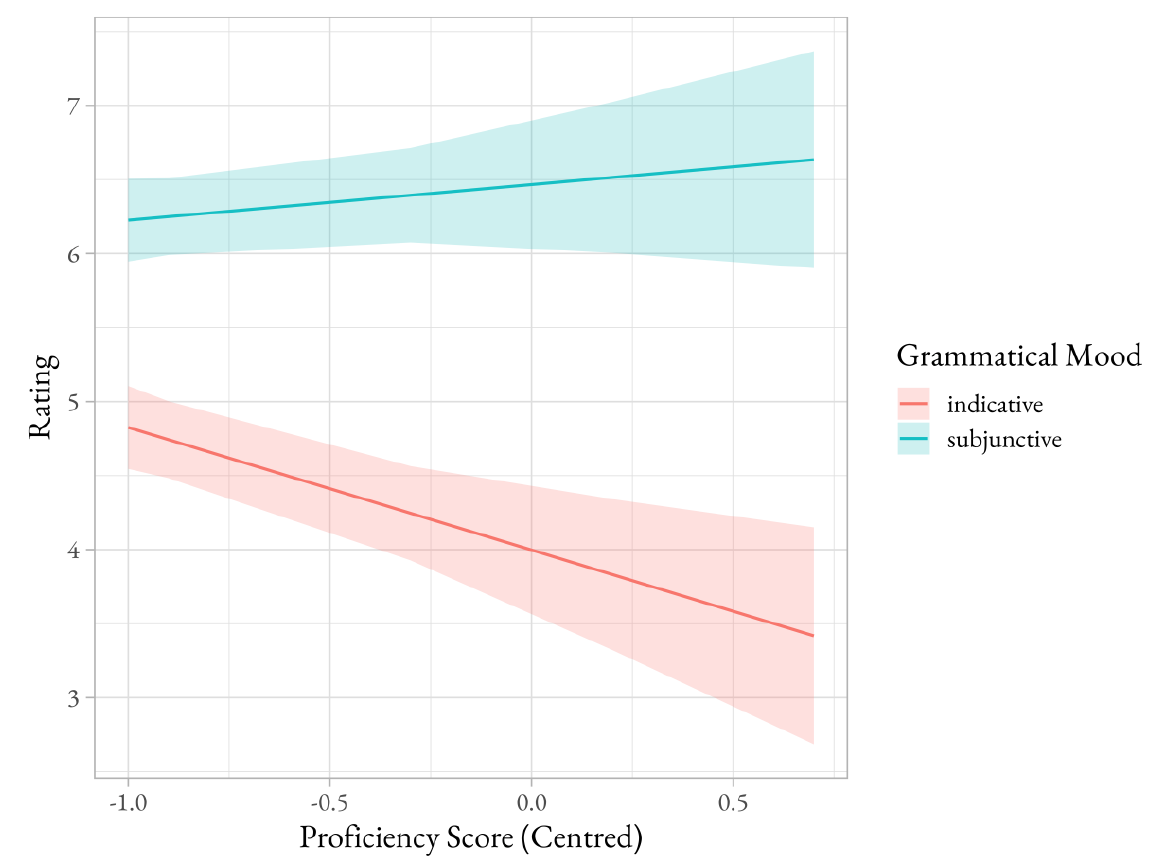
Figure 5. L2 judgment ratings of grammatical (subjunctive) and ungrammatical (indicative) sentences, as a function of proficiency.